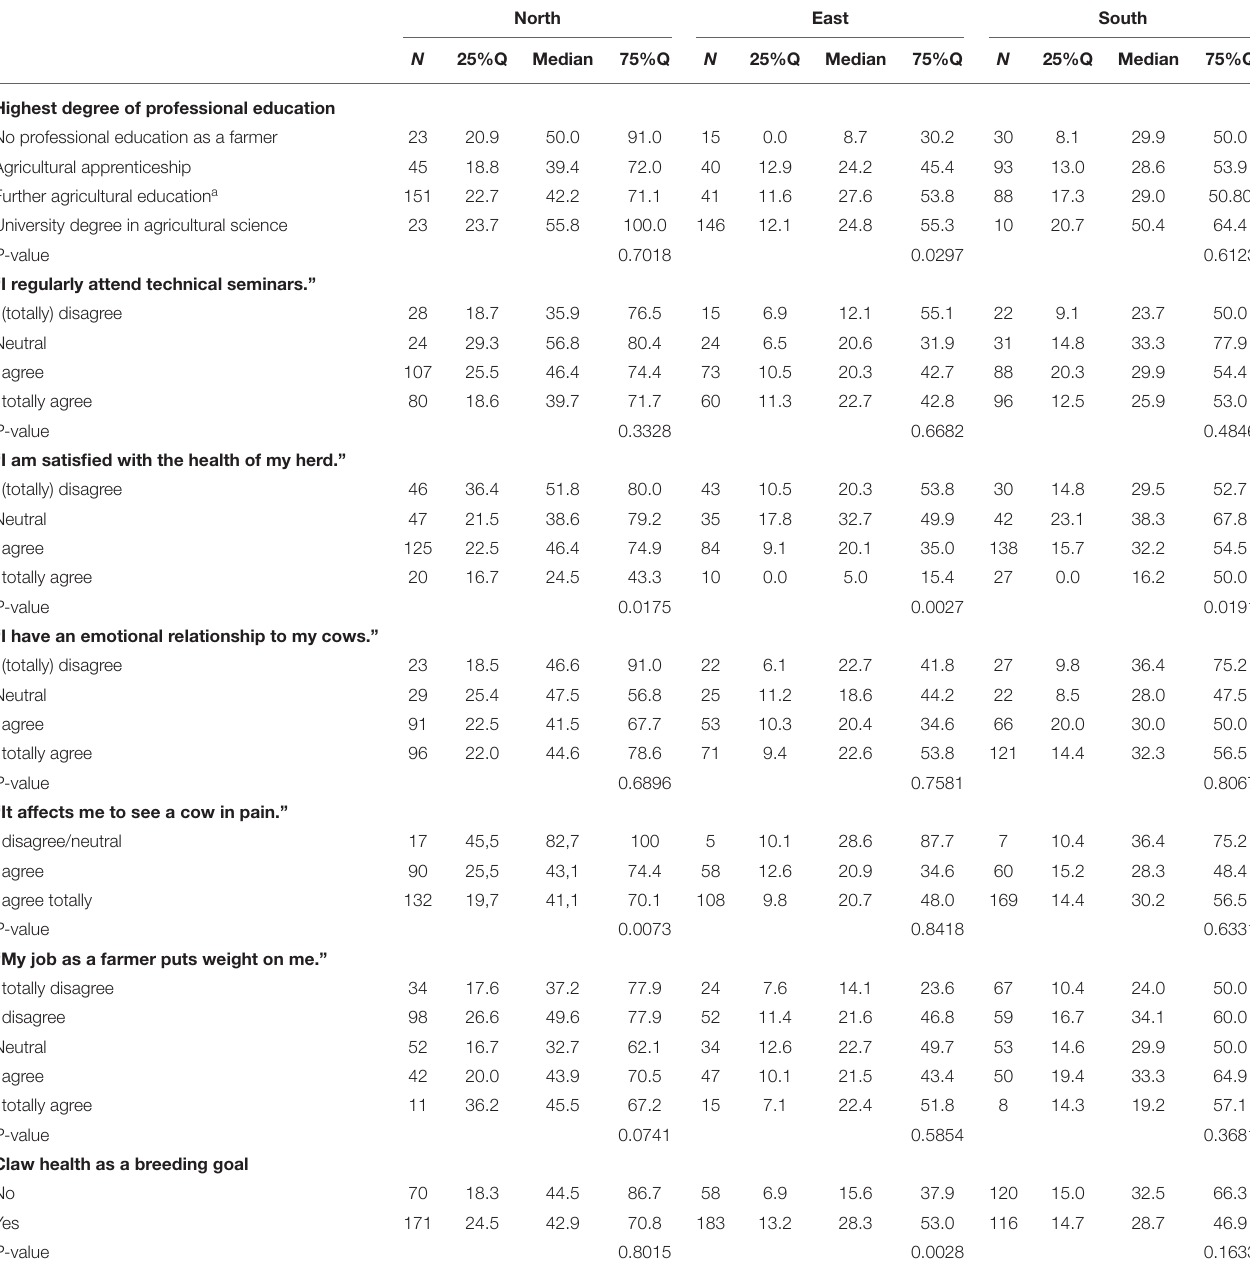
TABLE 6 | Association (Kruskal-Wallis-test) and descriptive analyses of Farmers’ Detection Index depending on farmer’s attitude and education. North East South N 25%Q Median